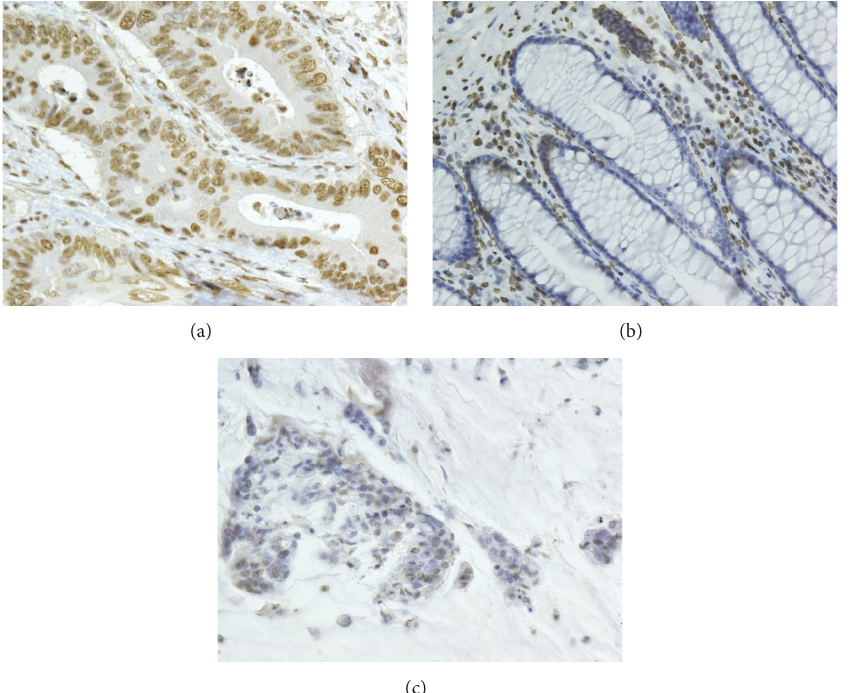
Figure 5: Expression of PPAR- 𝛼 in different histological types. (a) Positive PPAR- 𝛼 expression in well-to-moderately differentiated adenocarcinoma (200 × ). (b) Negative PPAR- 𝛼 expression in normal epithelium tissue (200 × ). (c) Negative PPAR- 𝛼 expression in mucinous adenocarcinoma (200 ×